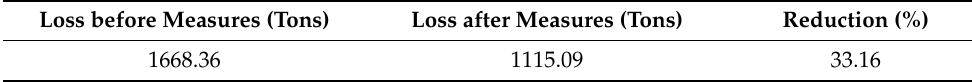
Table 4. Effect of the measures. Source: own